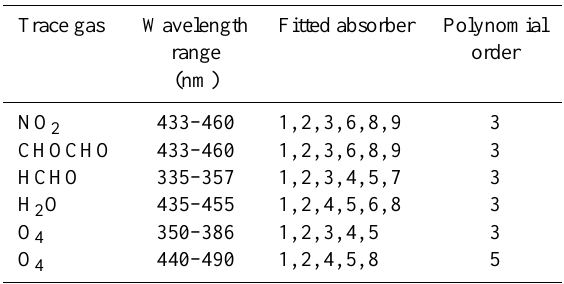
Table 2. Summary of DOAS analysis settings for different trace gases. 2 Rings (warm and cold) were fitted for HCHO retrievals, and spectra collected for SZA < ∼ 65 ◦ were only analyzed and hence BrO was not included in the fit.